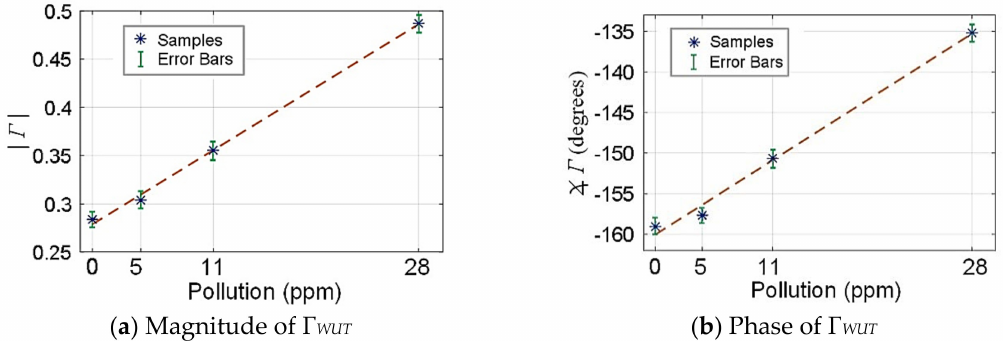
Figure 6. Measurement results of Γ WUT versus concentrations of pollution